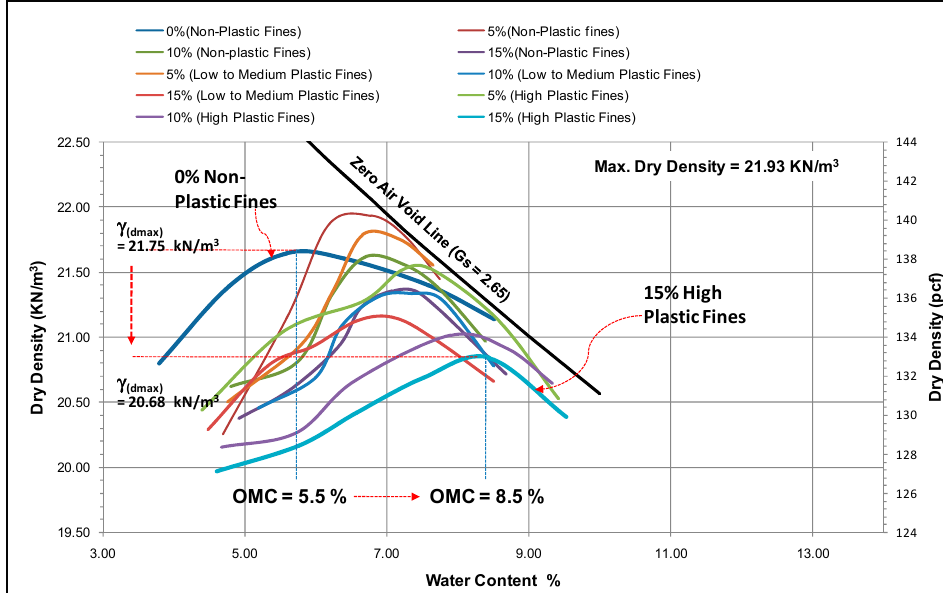
Figure 2. Compaction curves of the composite samples (gradation B).